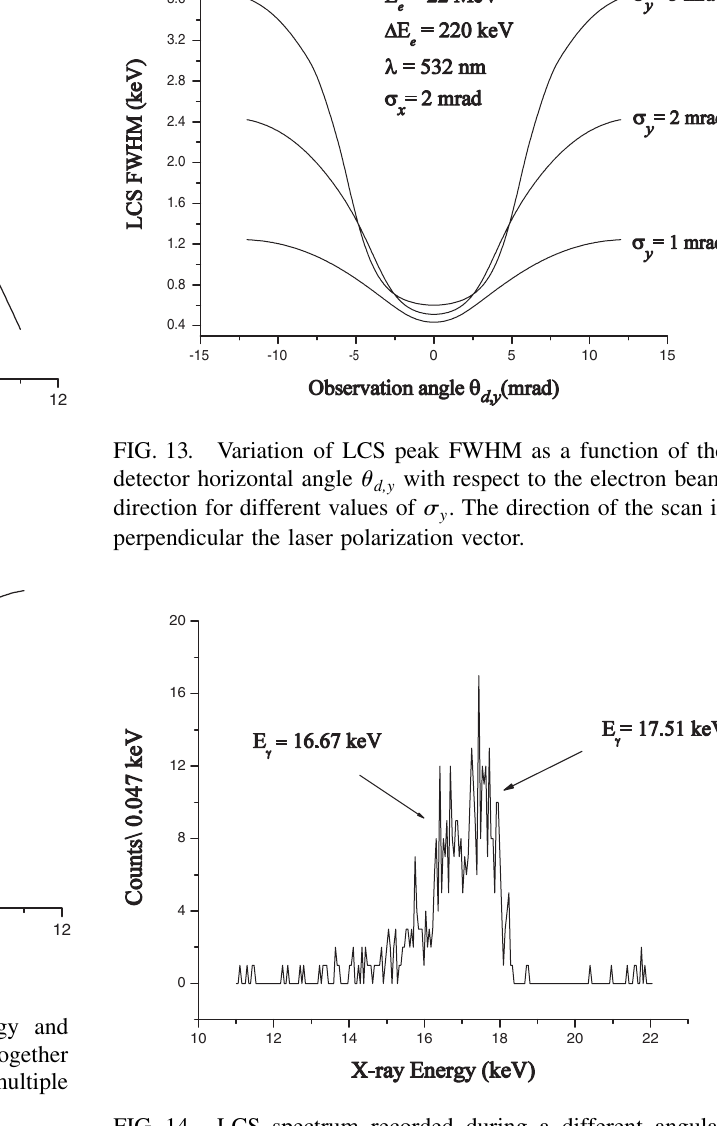
FIG. 14. LCS spectrum recorded during a different angular scan. The spectrum shows two peaks almost 1 keV apart. The lower peak is suspected to be due a drift in the electron beam direction. The FWHM of the combined peaks is twice as large as that of the higher energy peak.